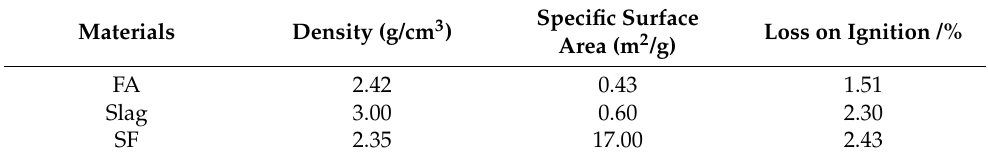
Table 2. Properties of the binders.